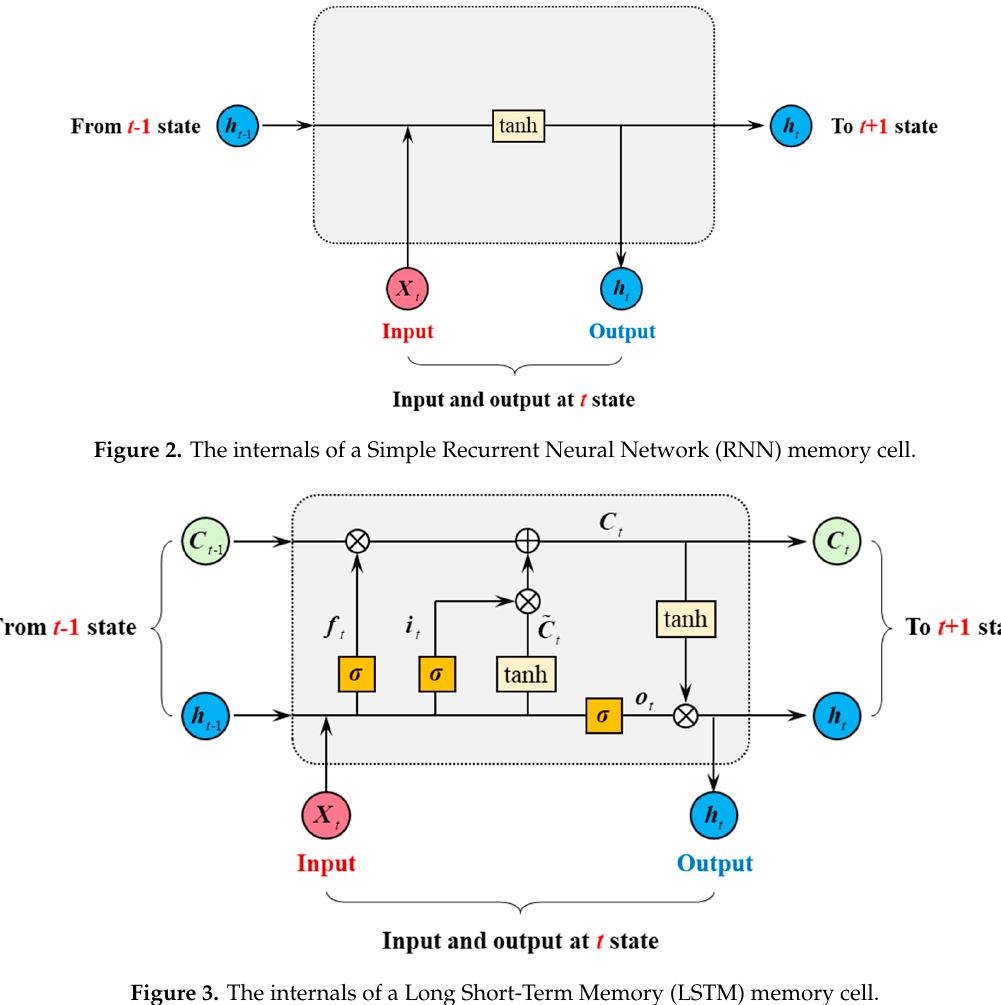
Figure 3. The internals of a Long Short-Term Memory (LSTM) memory cell.